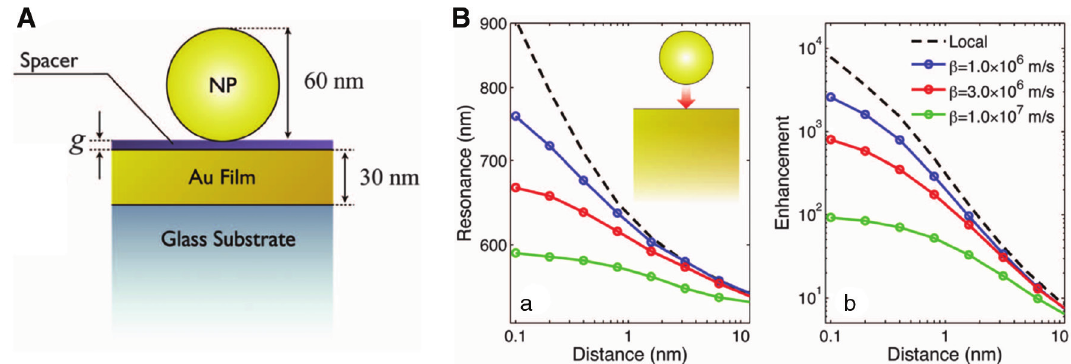
Figure 17: (A) System theoretically investigated in [43], where the nanosphere is separated from the metal film by a gap with size down to 1 Å; (B) both the plasmon mode wavelength and the field enhancement in the gap have been calculated with an hydrodynamic model, where β is a parameter proportional to the Fermi velocity. From C. Ciracì, R. T. Hill, J. J. Mock, Y. Urzhumov, A. I.